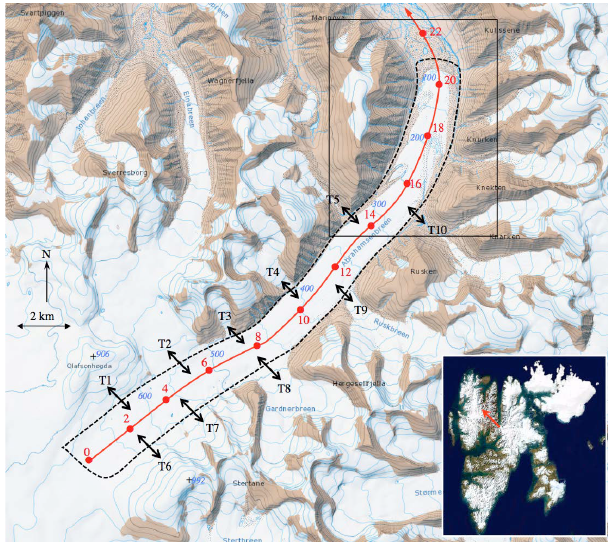
Figure 1. Map of Abrahamsenbreen in northern Spitsbergen (inset), originating from the ice field Holtedahlfonna (lower left corner of the map). The red line shows the flow line along which the length is defined; numbers in red indicate distance from the glacier head in kilometres. Basins and tributary glaciers delivering mass to the main stream are numbered T1–T5 (left) and T6–T5 (right). Isohypses on the glacier in metres above sea level are shown in blue. Glacier stand in 1990, i.e. after the 1978 surge. Note that looped moraines are ac- tually shown on the map. The rectangle in the upper part refers to the area covered by the aerial photograph of Fig. 2. Map is cour- tesy of the Norwegian Polar Institute; Landsat image is courtesy of NASA.